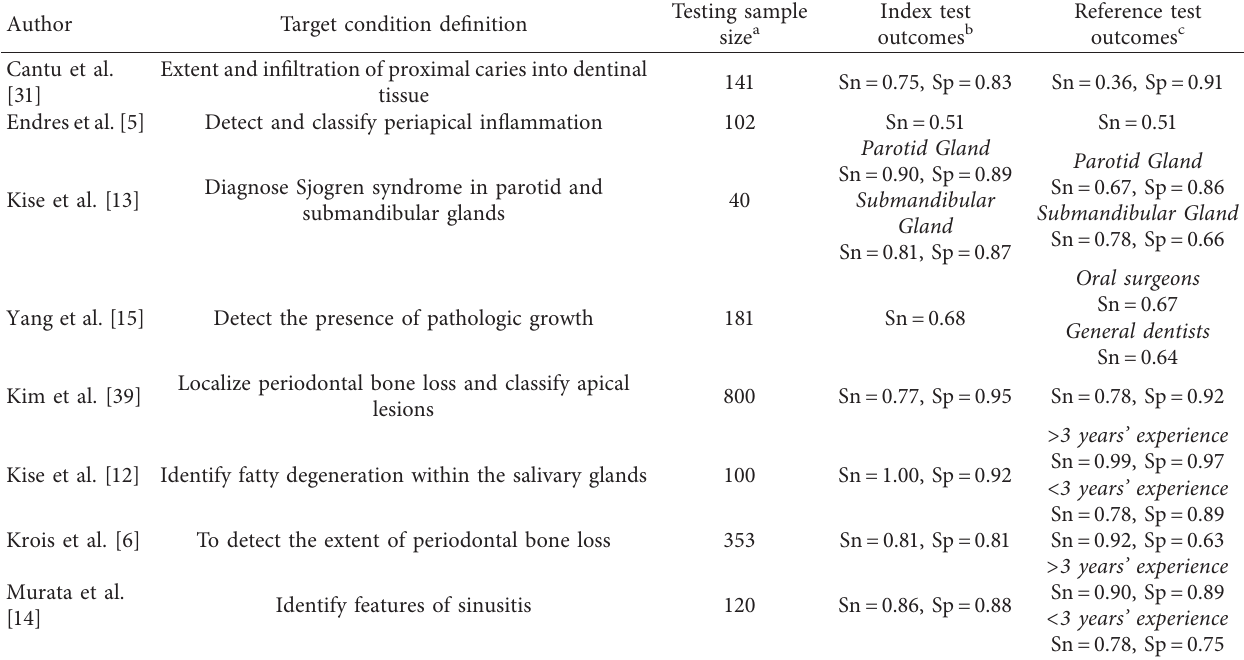
Table 1: Summary outcomes of studies comparing diagnostic